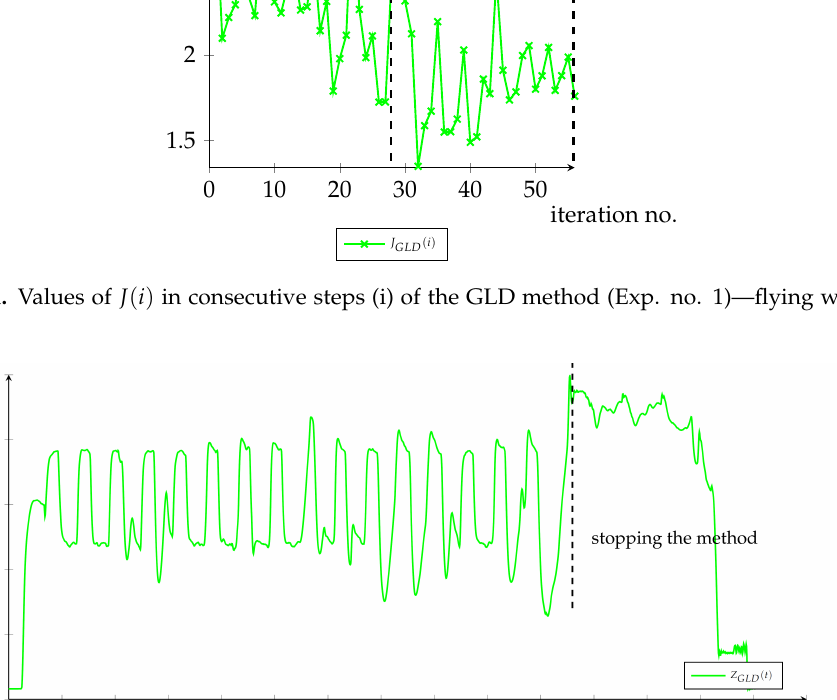
Figure 22. Time course from the real-world experiment (Exp. no. 1): tuning of the altitude controller during the UAV flight with an additional (heavy) mass (225